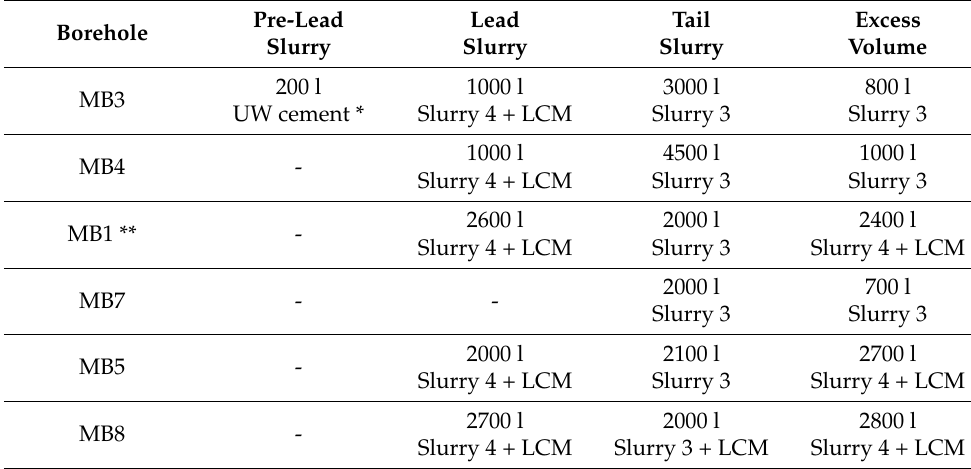
Table 6. Cement volumes and pumping sequences in chronological order.